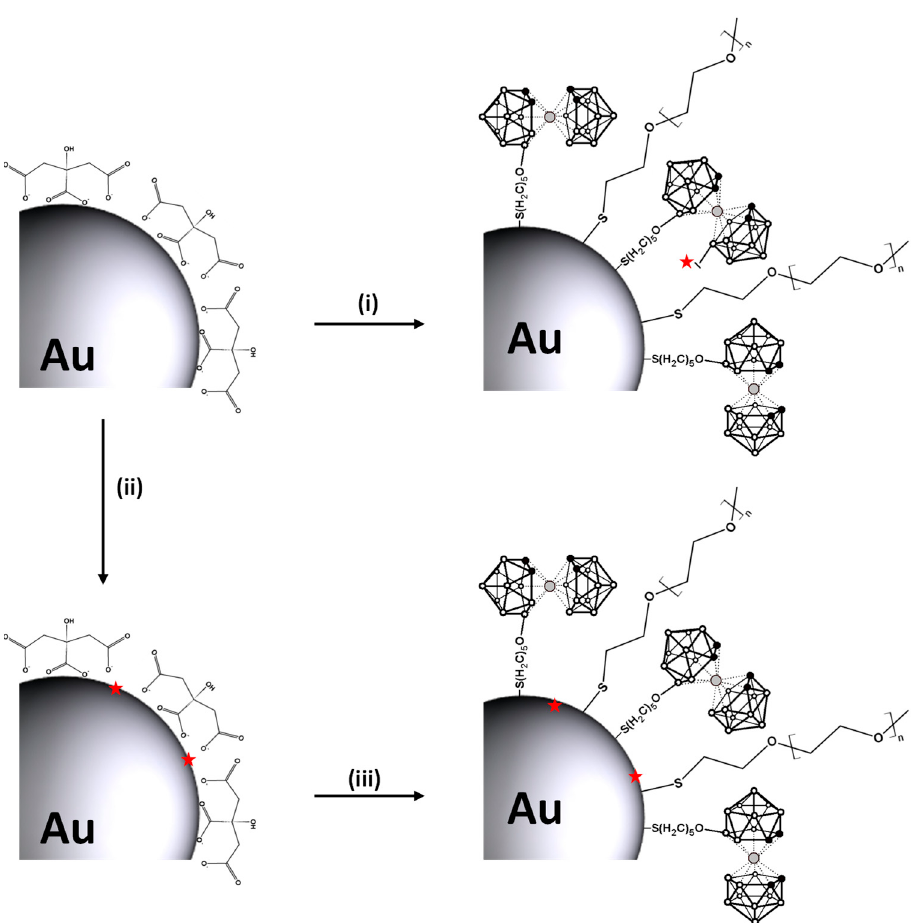
Figure 3. Schematic representation of the di ff erent routes followed for the preparation of radiolabelled PEG-AuNPs@[ 4 ] − . (i) PEG-SH (5 Kda), 124 I-[ 6 ] − + [ 4 ] − ; (ii) [ 124 I]NaI; (iii) PEG-SH (5 Kda), [ 4 ] − . The red star stands for the radiolabel ( 124 I).